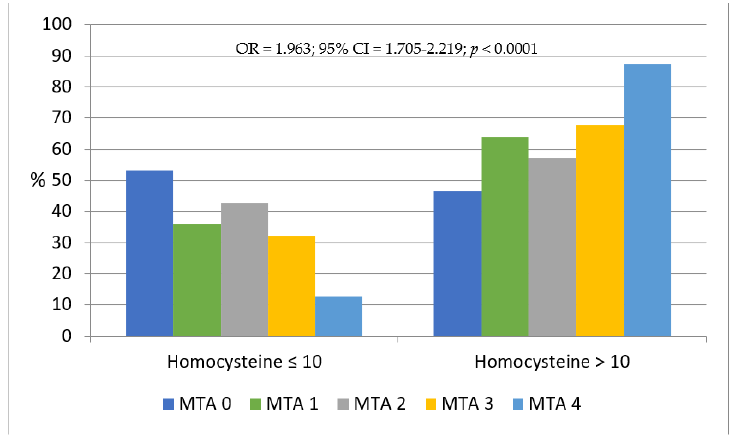
Figure 1. Distribution of MTA score according to homocysteine levels. Legend: MTA , Medial Temporal Lobe Atrophy; % , percentage of homocysteine level distributions.